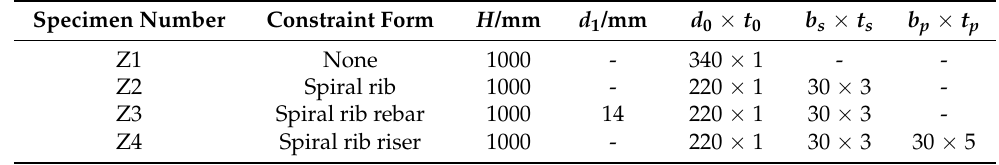
Figure 2. Cross-sectional form diagram. ( a ) Ordinary steel pipe; ( b ) Spirally ribbed steel pipe; ( c ) Rebar spirally ribbed steel pipe; ( d ) Vertical-plate spirally ribbed steel pipe. Table 1. Specimen parameters.